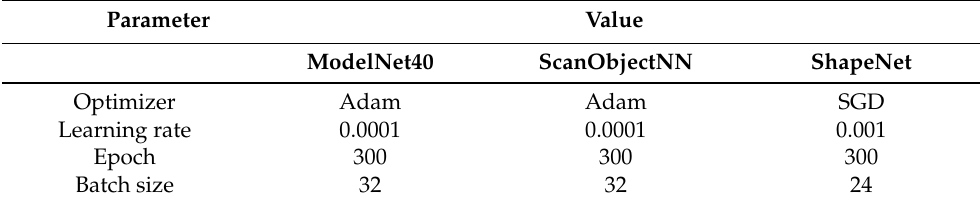
Table 2. Hyperparameter settings of our